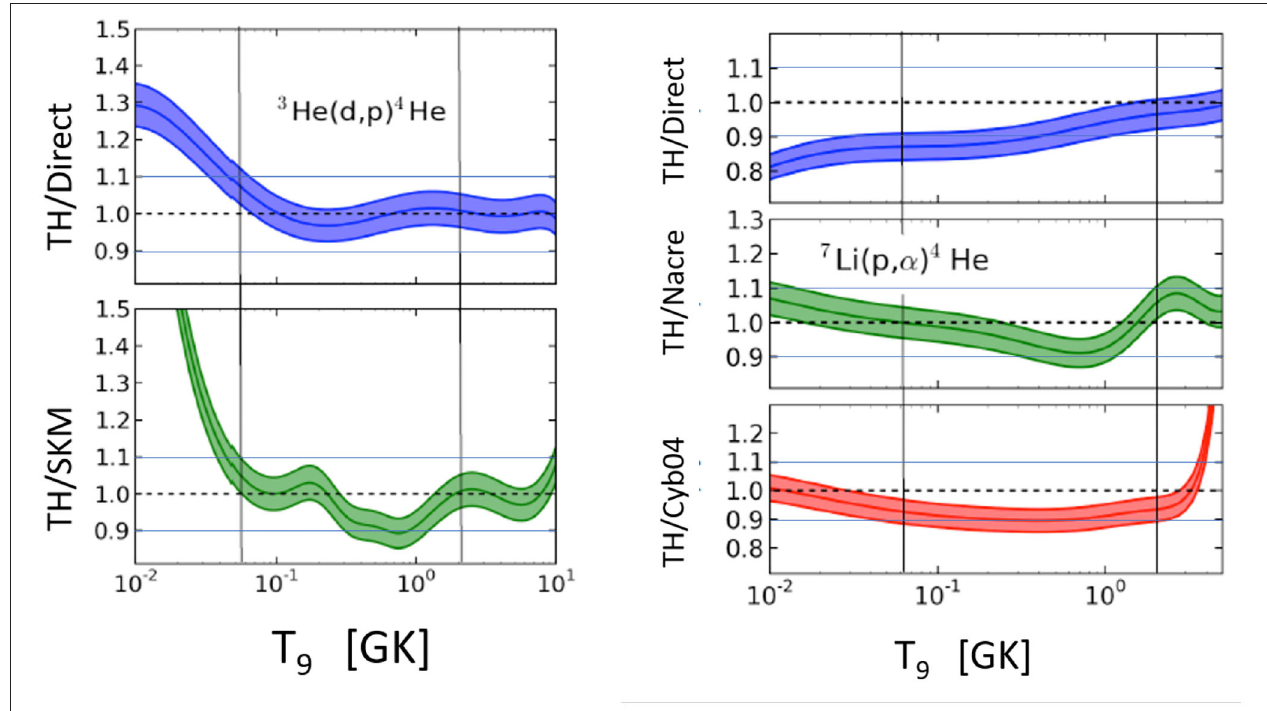
FIGURE 9 | (Left) Trojan Horse 3 He(d,p) 4 He reaction rates as a ratio to the one obtained from direct data fit in the upper panel; the middle panel shows the same as a ratio to rate in Smith et al. (1993). Lower and upper temperature of interest for BBN are marked by the vertical lines. Blue lines define the ± 10% deviation from the unity. The figure is adapted from Pizzone et al. (2014). (Right) 7 Li(p, α ) 4 He reaction rates ratios from THM to the one obtained from direct data (upper panel), while in the middle and lower panels there TH rates ratios with rates published in NACRE (Angulo et al., 1999; Cyburt, 2004). Lower and upper temperatures of interest for BBN are marked by the vertical lines. Blue lines define the ± 10% deviation from the unity. The figure is adapted from Pizzone et al. (2014).